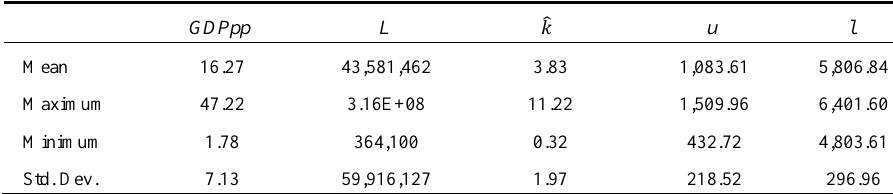
Table 1: Summary